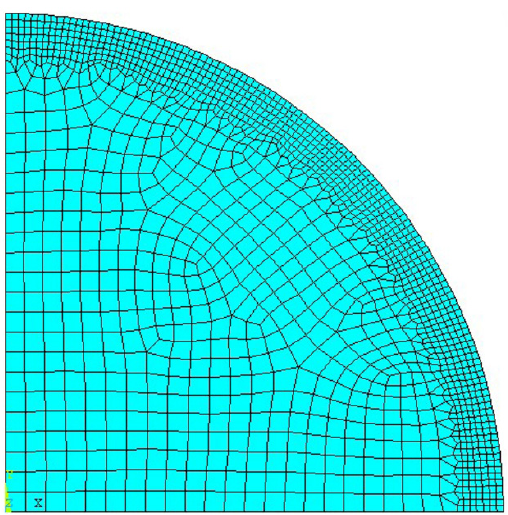
Figure 2. Finite element model of